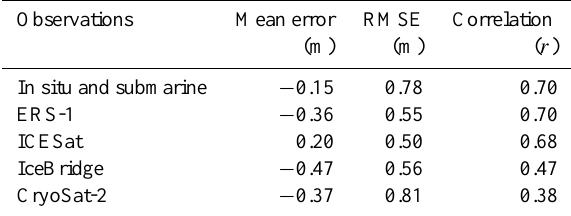
Table 2. Mean ice thickness bias, root-mean-square error estimate and correlation between PIOMAS modeled ice thickness and thick- nesses from different remotely sensed data